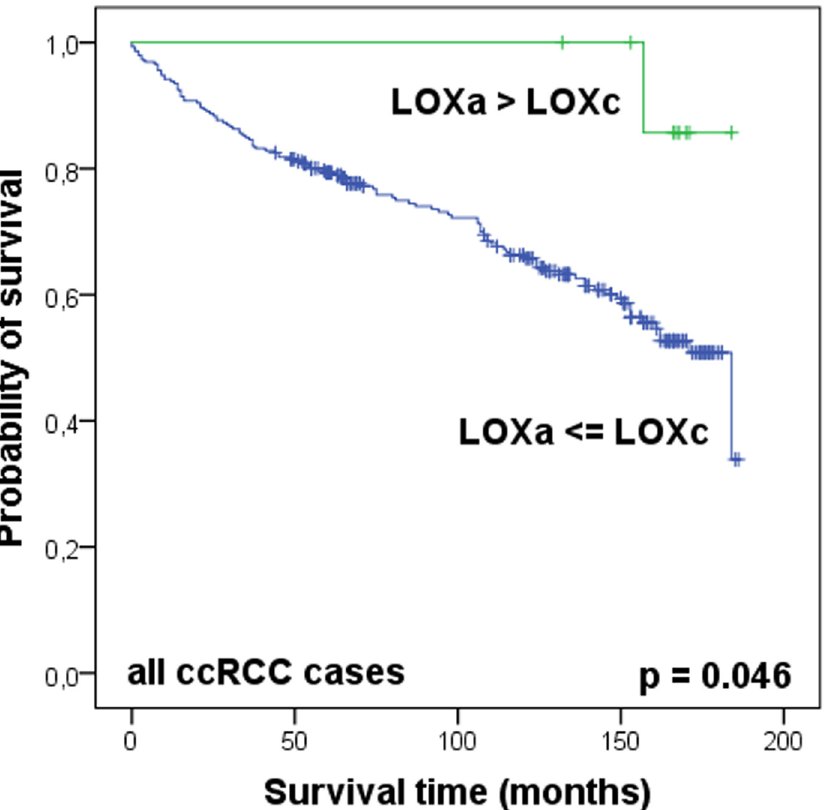
Fig 7. LOX expression pattern seems to be a prognostic marker in ccRCC. Kaplan-Meier analysis shows LOX staining pattern connected with overall survival of the patients after nephrectomy. Higher apical than cytoplasmic LOX staining was significantly associated with an increase in overall survival. Log rank